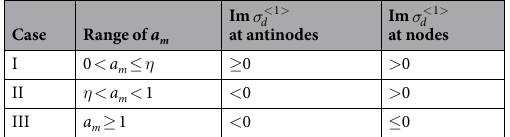
Table 1. The three cases of the standing-wave driven CPO